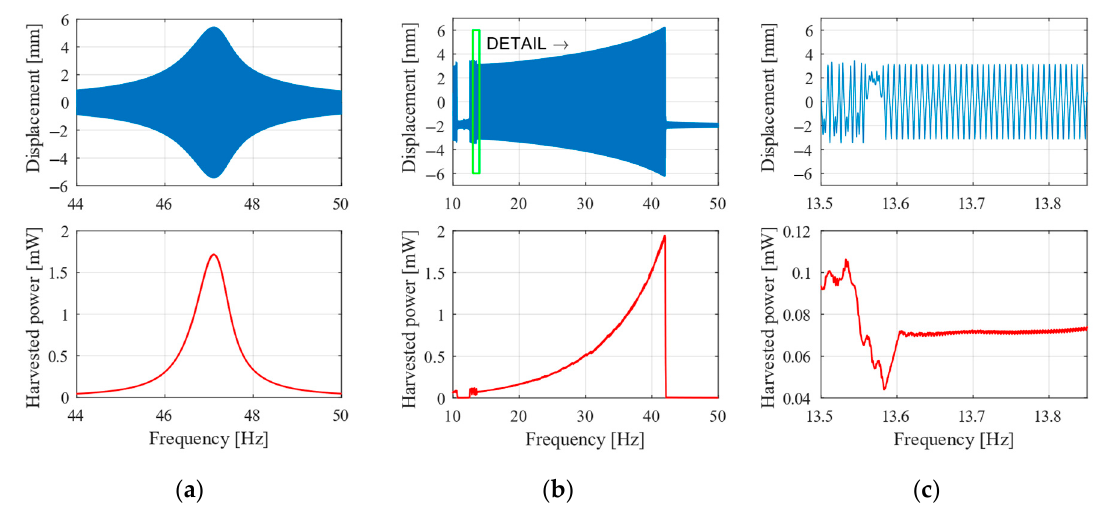
Figure 3. Sweep up with amplitude 0.9 g. ( a ) Linear, ( b ) nonlinear oscillator, and ( c ) detail of nonlinear oscillations.